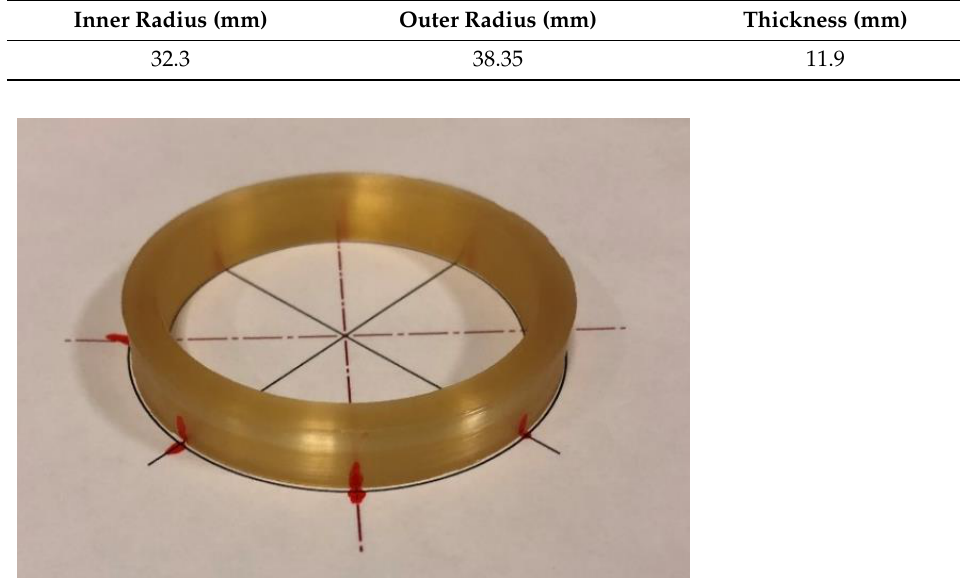
Figure 1. Type-1 fiber-optic coil.